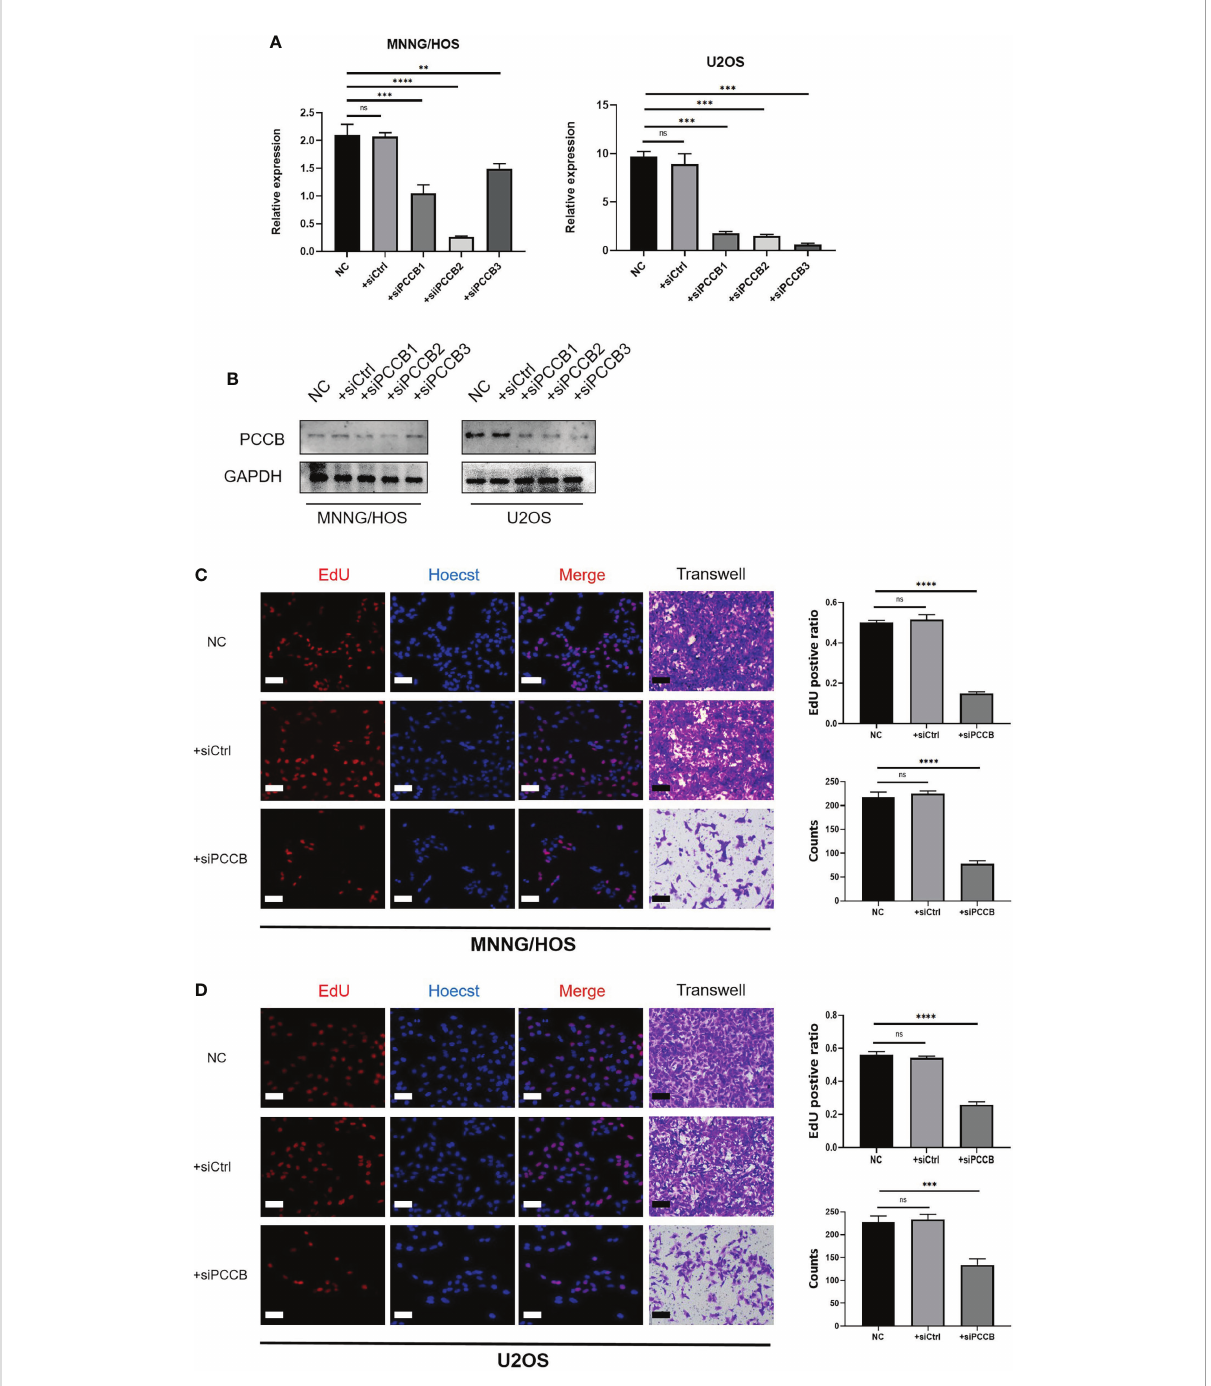
FIGURE 7 In vitro validation on PCCB. (A) RT-qPCR results of the expression of PCCB in fi ve groups (NC, si-NC, si-PCCB-1, si-PCCB-2, si-PCCB-3) in two cell lines. (B) Western blot results of the expression of PCCB in fi ve groups (NC, si-NC, si-PCCB-1, si-PCCB-2, si-PCCB-3) in two cell lines. (C) EdU assay in three groups (NC, si-NC, si-PCCB) in the MNNG/HOS cell line. Statistical analysis was based on mean ± SD. (D) EdU assay in three groups (NC, si-NC, si-PCCB) in the U2OS cell line. Statistical analysis was based on mean ± SD. The si-PCCB refers to siRNA transfection of PCCB. The si-NC refers to siRNA transfection of nonspeci fi c control. ns, no signi fi cance; **p < 0.01; ***p < 0.001;****p <